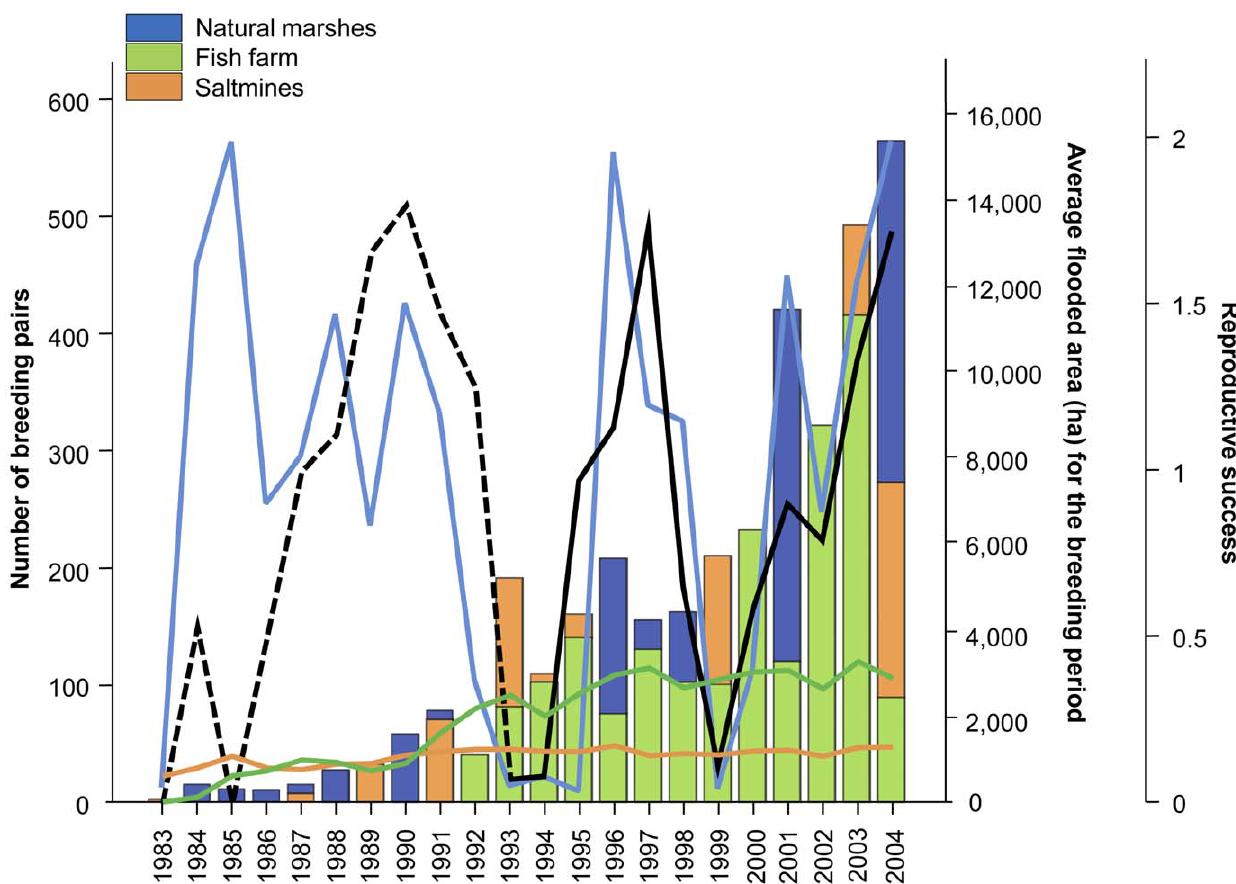
Figure 2. Linking natural resource availability with reproductive performance. Long-term (1983–2004) evolution of: bars= number of breeding pairs for the Slender-billed Gull population breeding at the Natural Area of Don˜ana (split by breeding site); colored lines= average extent of the flooded area for the natural marshes (blue), the fish farm (green; data for the 1983–1991 period refer to the flooded area of the former marshland that was transformed for commercial fish farming in 1992) and the saltmines (orange) during the Slender-billed gull breeding period (April-July); black line= overall reproductive success of the Slender-billed gull population (dashed black line represents the estimated reproductive success before 1993, which have been estimated based on few and non systematic direct observations and have not been considered in the analyses, see Material and Methods).